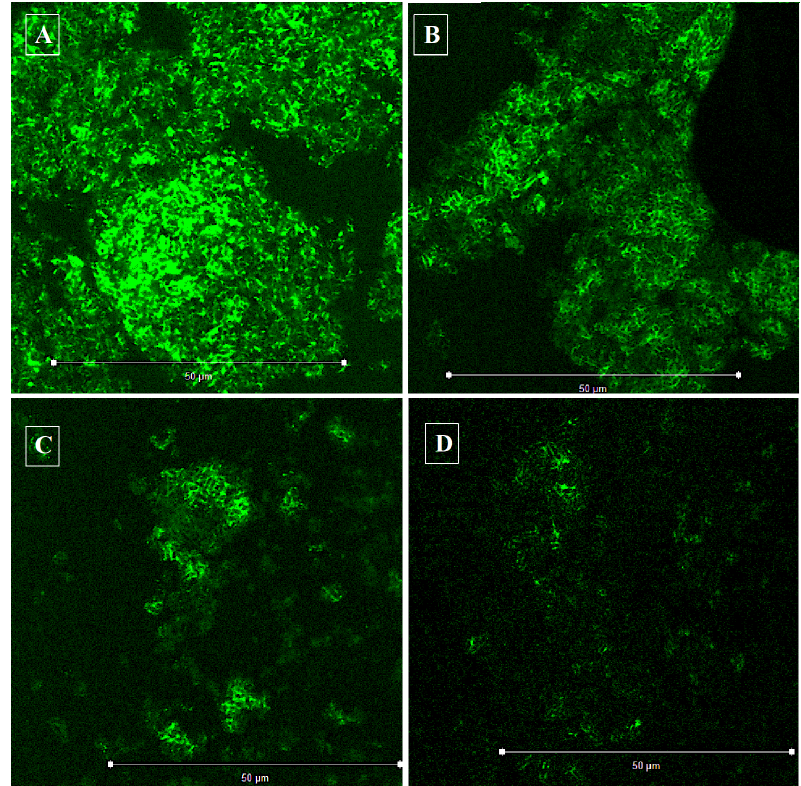
Figure 10. Percentage of biofilm formation in treated and untreated C. violaceum . The percentage of biofilm formation was determined by staining treated and untreated C. violaceum cells with 0.1% crystal violet solution. The control bar indicates untreated cells, accepted as 100% biofilm-forming cells. Data represents means ± SD of three different values; * p ≤ 0.01.